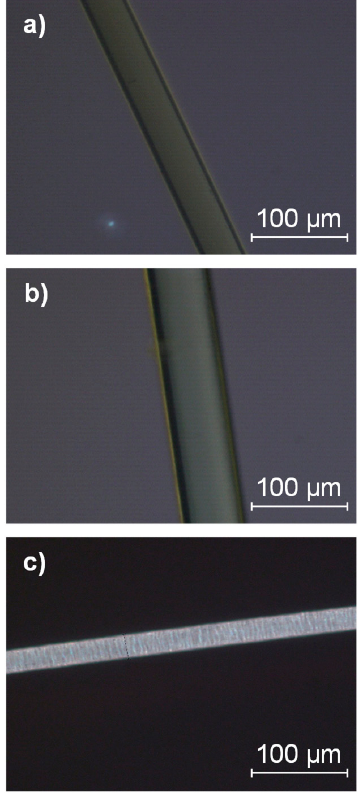
Figure 13. POM images. ( a ) Melt-electrospun PLA fiber. ( b ) Partially oriented PLA filament. ( c ) Drawn PLA filament.